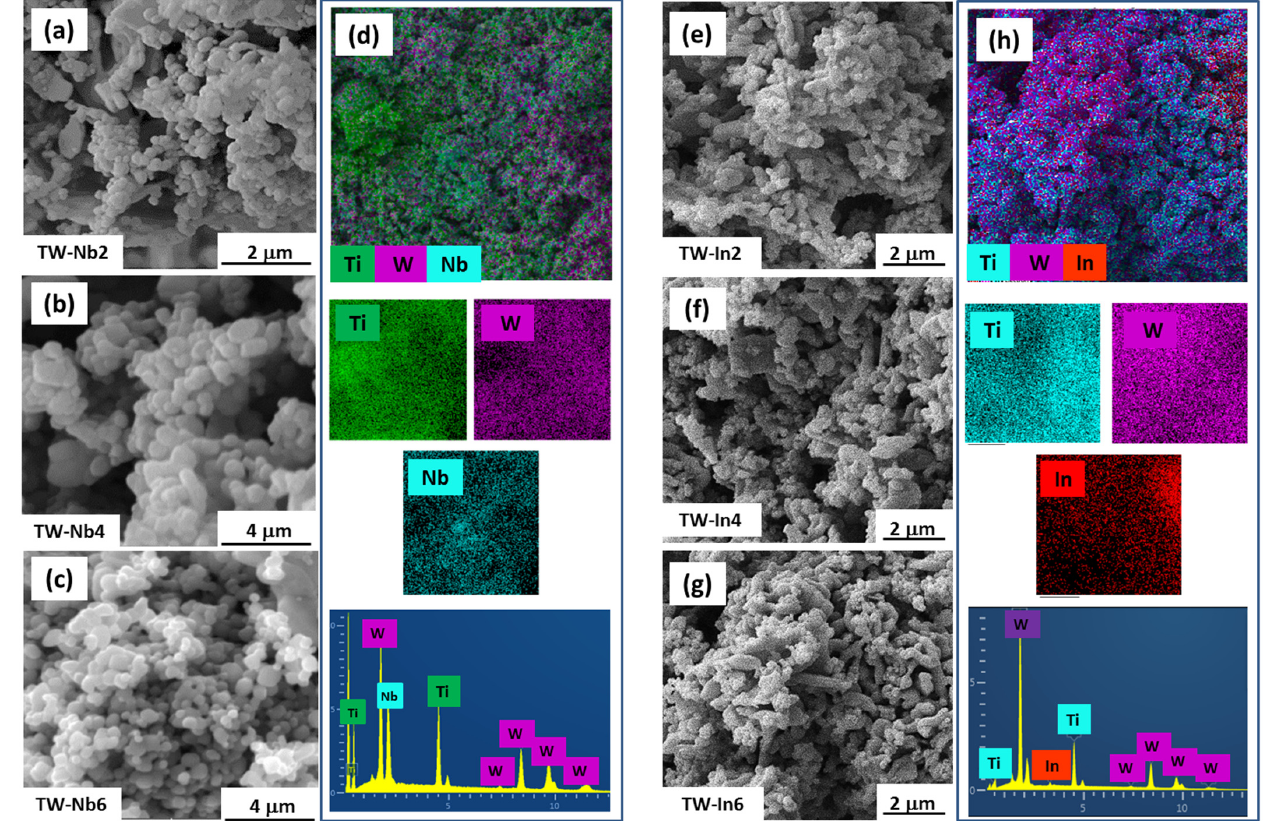
Figure 3. SEM images of Nb -doped ( a ) TW − Nb 2, ( b ) TW − Nb 4 and ( c ) TW − Nb 6 and In -doped ( e ) TW − In 2, ( f ) TW − In 4 and ( g ) TW − In 6 sintered MMO; EDX elemental composition and mapping of ( d ) TW − Nb 4 and ( h ) TW − In 4